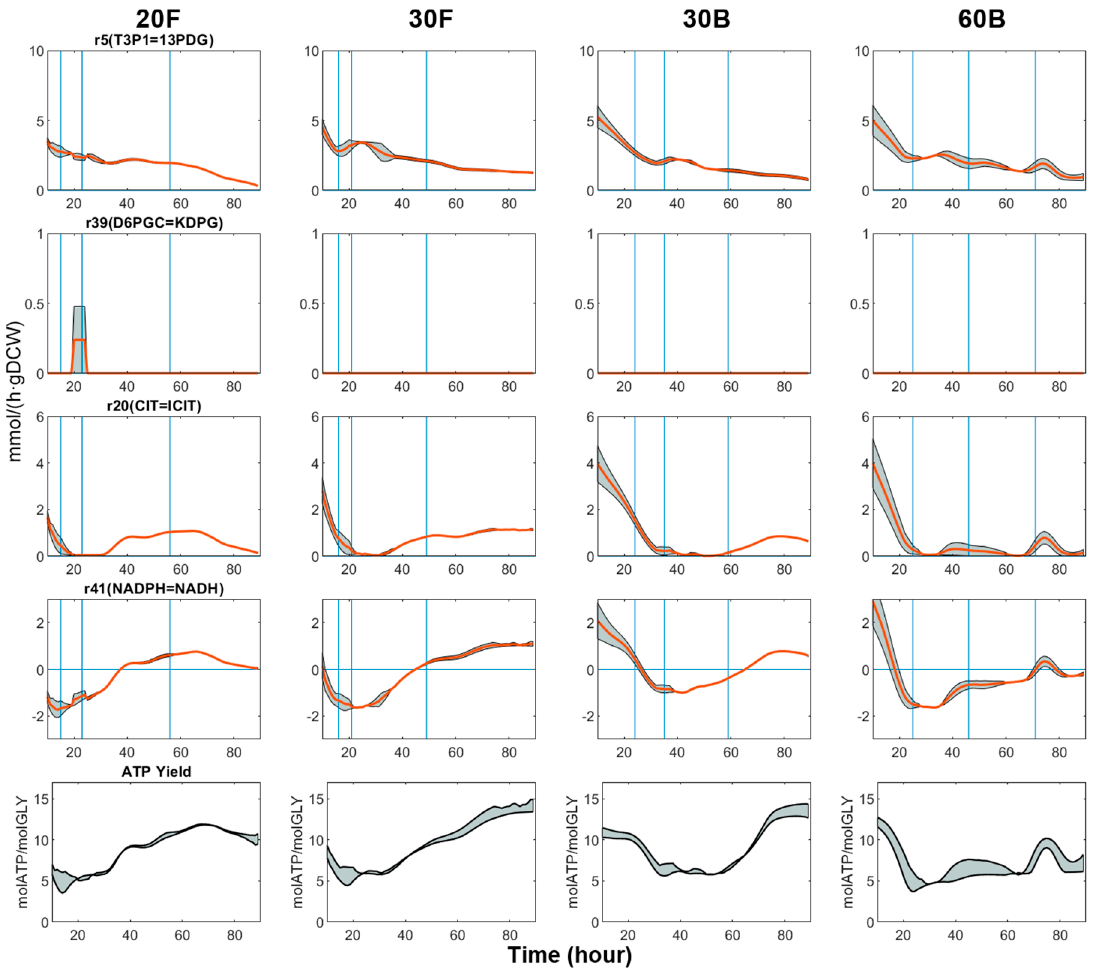
Figure 6. Flux profiles for glycolysis (r5), the ED pathway (r39), TCA cycle (r20), NAD(P)+ transhydrogenation (r41) and ATP yield (molATP/molGLY) profiles. Time range: 10–90 h.